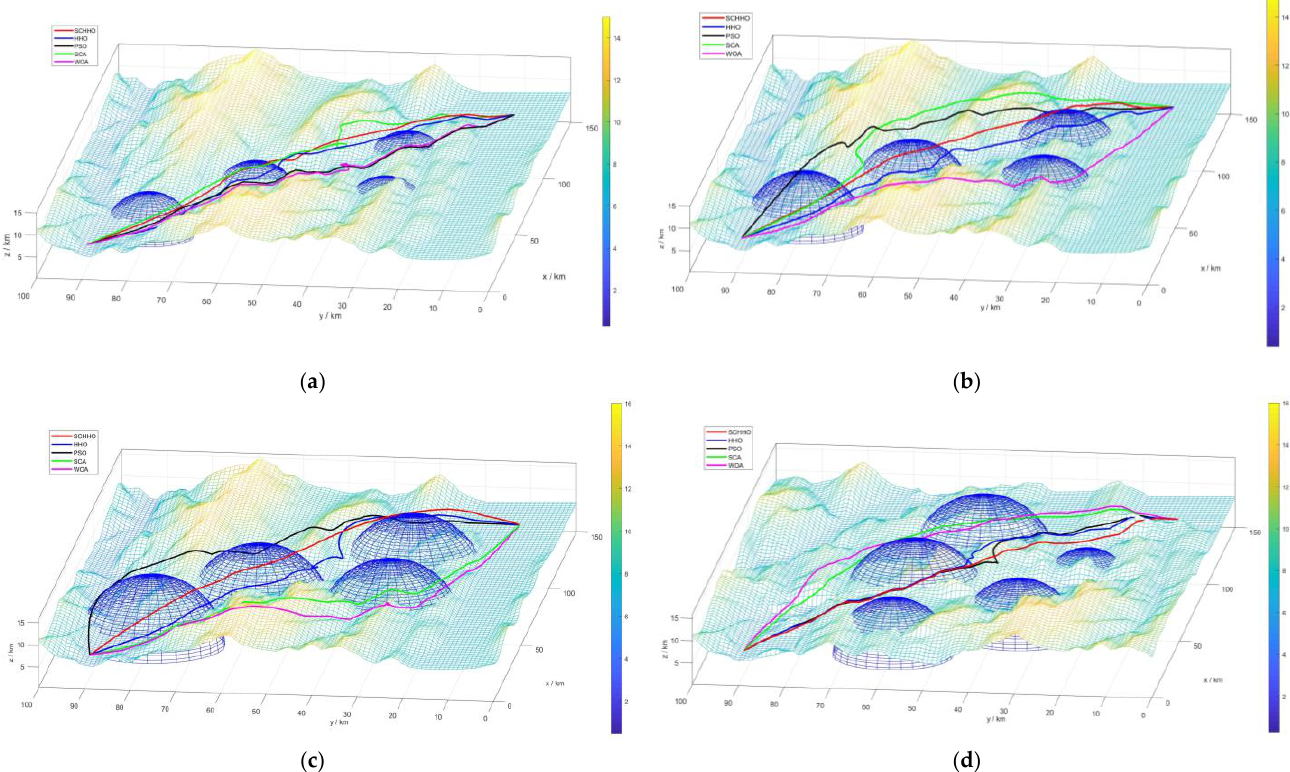
Figure 6. Path planning results in 3D simulation map. ( a ) Case 1. ( b ) Case 2. ( c ) Case 3. ( d ) Case 4.